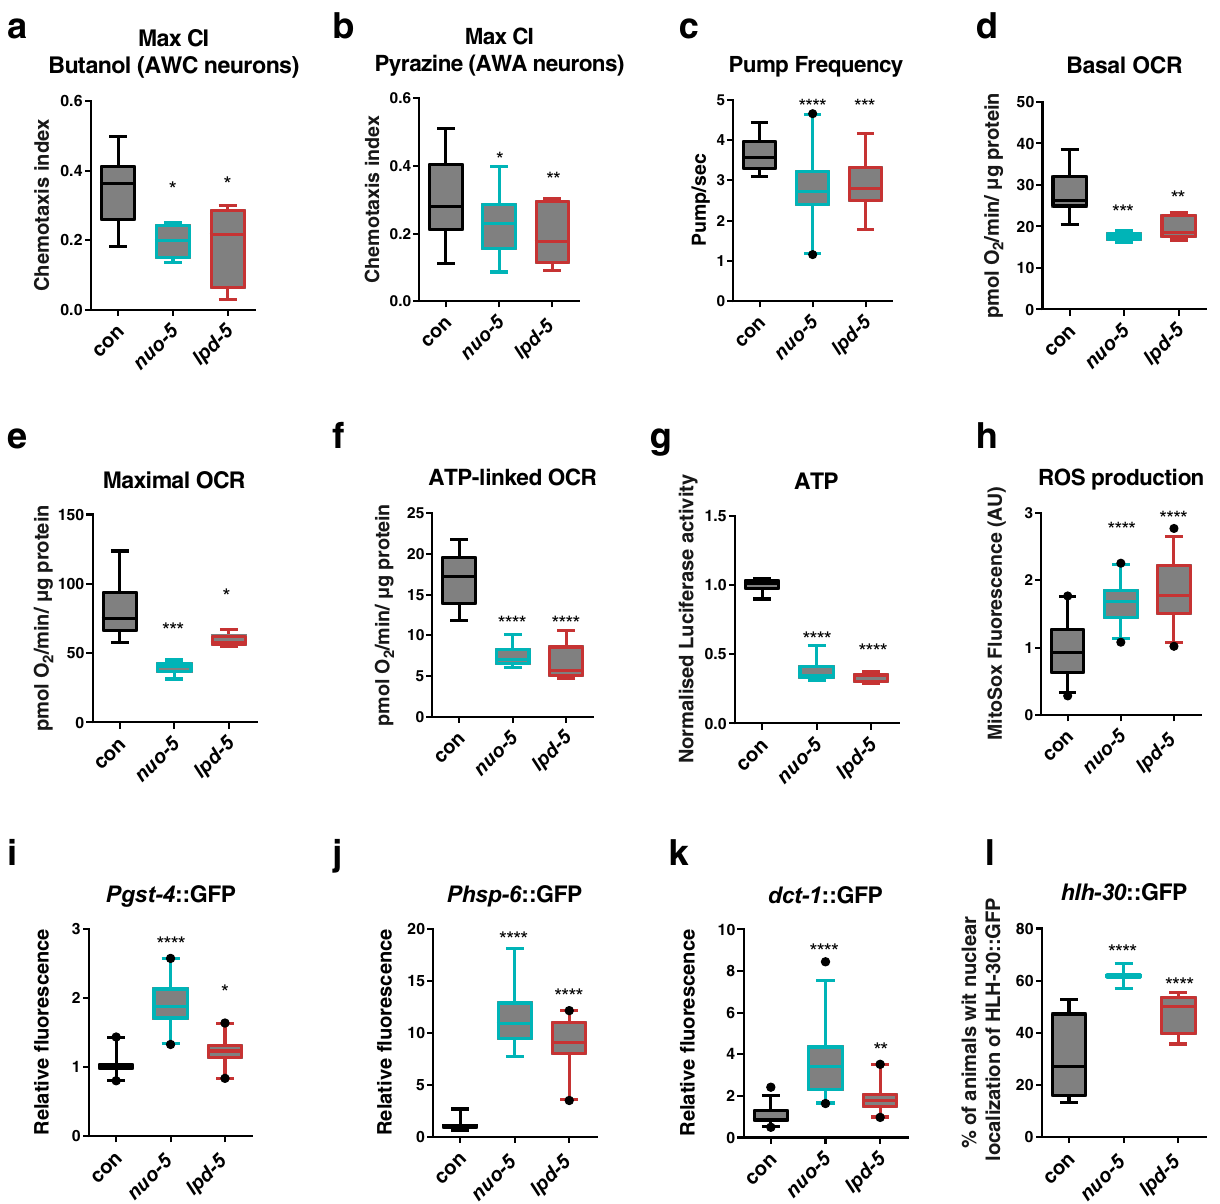
Fig. 2 Severe suppression of Complex I genes signi fi cantly impairs sensory neurons and mitochondrial functionality. Animals were fed bacteria transformed either with empty-vector (con) or with vector expressing dsRNA against nuo-5 or lpd-5 . a , b Chemotaxis index reached after 240 minutes in response to 1% Butanol ( n ≥ 630) or 1% Pyrazine ( n ≥ 610), over three biologically independent experiments. p values in a : con vs nuo-5 p = 0.024, con vs lpd-5 p = 0.019. p values in b : con vs nuo-5 p = 0.032, con vs lpd-5 p = 0.0082. c Pharyngeal Pump frequency was measured using the ScreenChipTM System (InVivo Biosystems). n ≥ 30 over two (for lpd-5 ) or four (for nuo-5 ) biologically independent experiments. con vs nuo-5 p < 0.0001, con vs lpd-5 p = 0.0003. d – f Basal OCR, maximal OCR and ATP-linked OCR were measured using the Seahorse XF24 Analyzer. n ≥ 3750 over three biologically independent experiments. p values in d : con vs nuo-5 p = 0.0007, con vs lpd-5 p = 0.0039. p values in e : con vs nuo-5 p = 0.0003, con vs lpd-5 p = 0.0319. p values in f : con vs nuo-5 p < 0.0001, con vs lpd-5 p < 0.0001. g ATP production was measured using the luciferase-expressing strain PE255 n ≥ 1000 over three biologically independent experiments. **** p values < 0.0001. h ROS production was measured with MitoSOX Red, n ≥ 50 over two biologically independent experiments. **** p values < 0.0001. i P gst-4 ::GFP expression, n ≥ 65 over four biologically independent experiments. con vs nuo-5 p < 0.0001, con vs lpd-5 p = 0.022. j P hsp-6 ::GFP expression, n ≥ 50 over four biologically independent experiments. **** p values < 0.0001. k P dct-1 ::DCT-1::GFP expression, n ≥ 36 over two biologically independent experiments. p values: con vs nuo-5 p < 0.0001, con vs lpd-5 p = 0.0072. l P hlh-30 ::HLH-30::GFP expression, n ≥ 56 over four biologically independent experiments. **** p values < 0.0001. In all fi gure ’ s panels box plots indicate median (middle line), 25th, 75th percentile (box) and 5th and 95th percentile (whiskers) as well as outliers (single points). One-way ANOVA. Data for all panels are provided as a Source Data fi